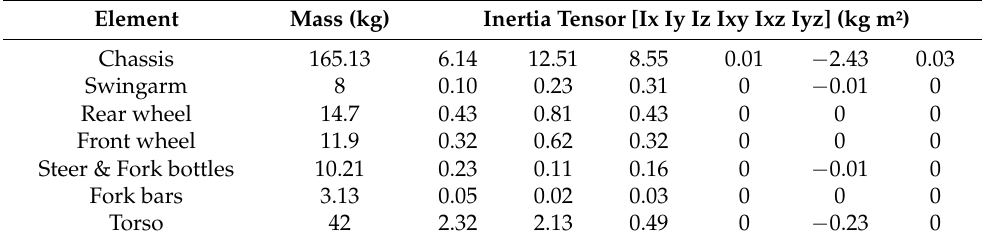
Table 1. Mass and inertial properties of all the model